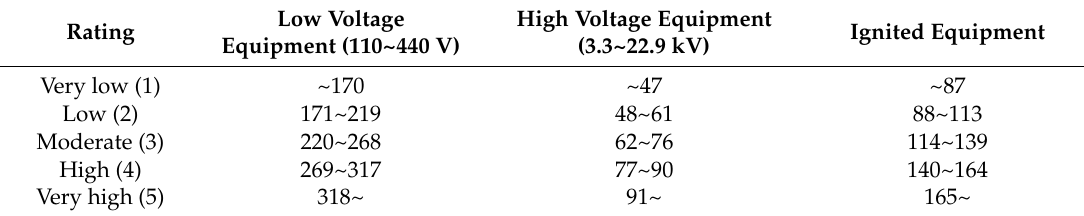
Table 7. The risk rating scale for electrical equipment.